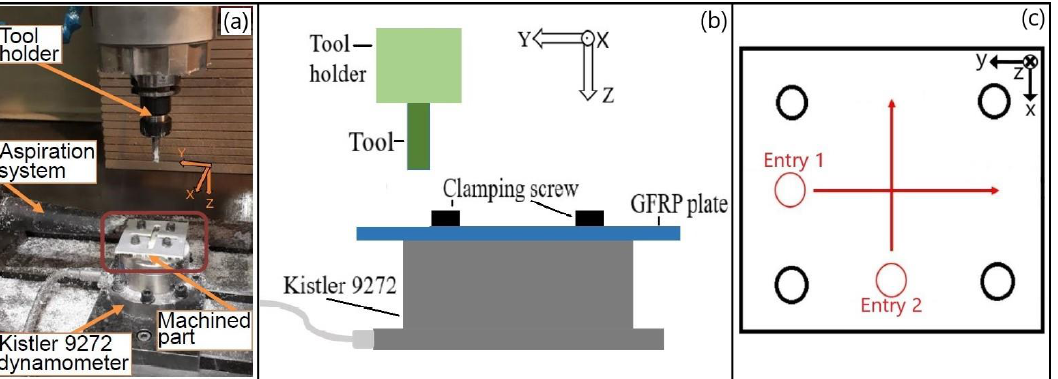
Figure 3. ( a ) Experimental setup; ( b ) Schematic representation of the clamping system of the GFRP coupon on the dynamometer and; ( c ) Tool path.